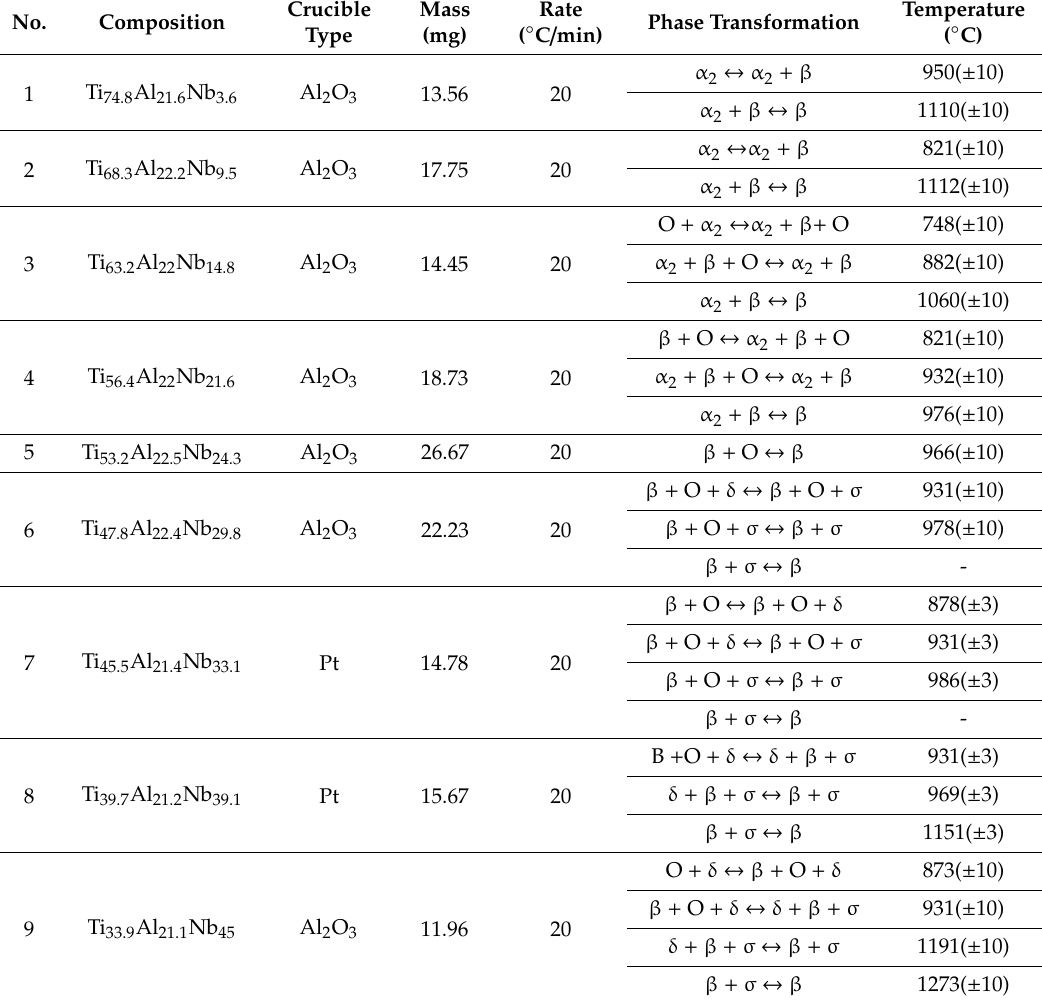
Table 4. The phase transformation and temperature of Ti-22Al- x Nb polythermal section annealed at 1000 ◦